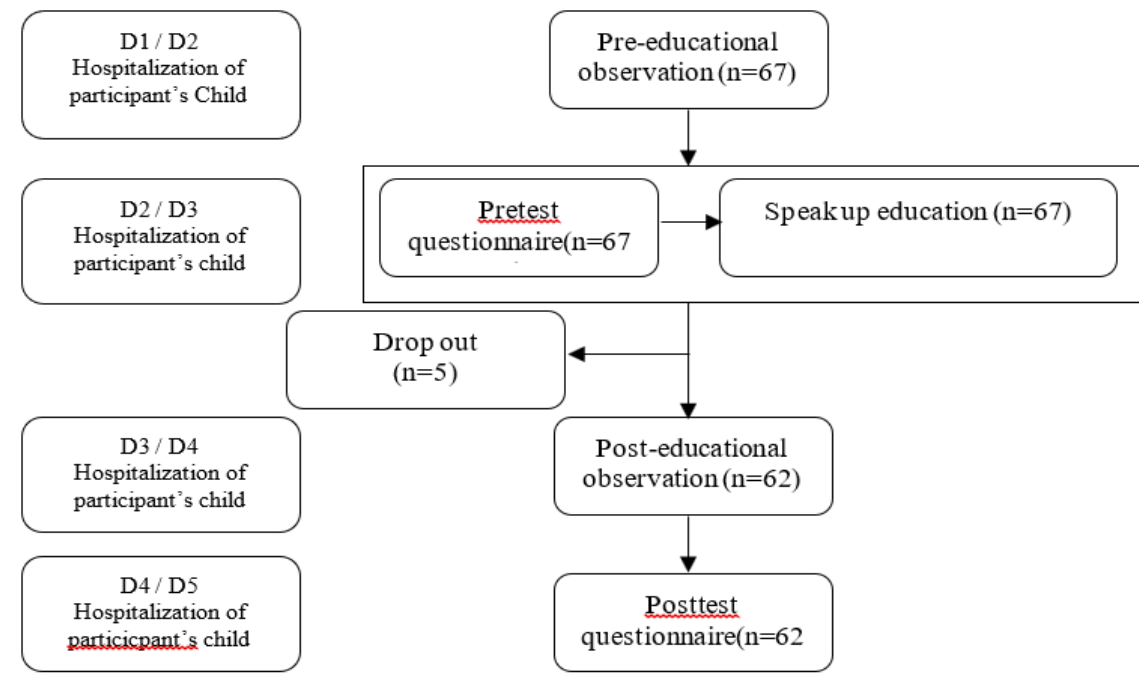
Figure 1. The flow of the